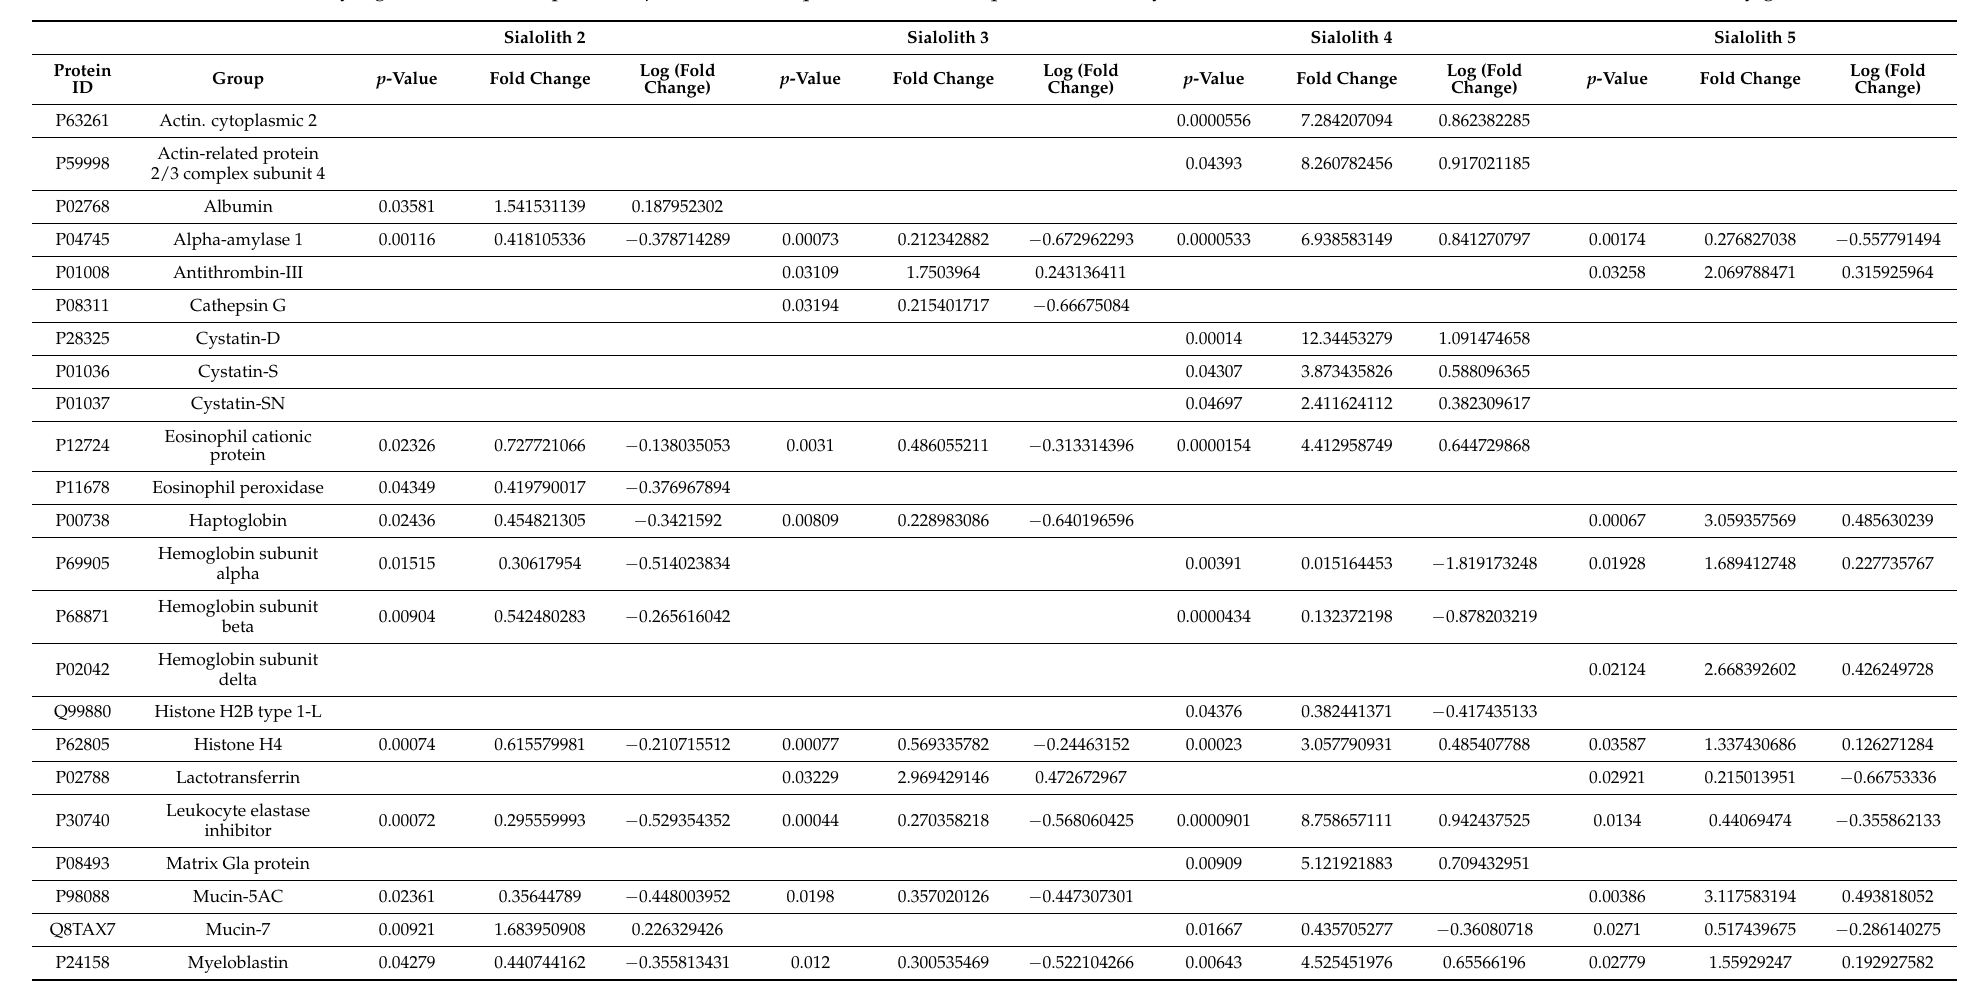
Table 1. Statistically significant sialolith proteins ( p -value < 0.05) qualified based on quantitative analysis as candidates for biomarkers of the formation of salivary glands. Sialolith